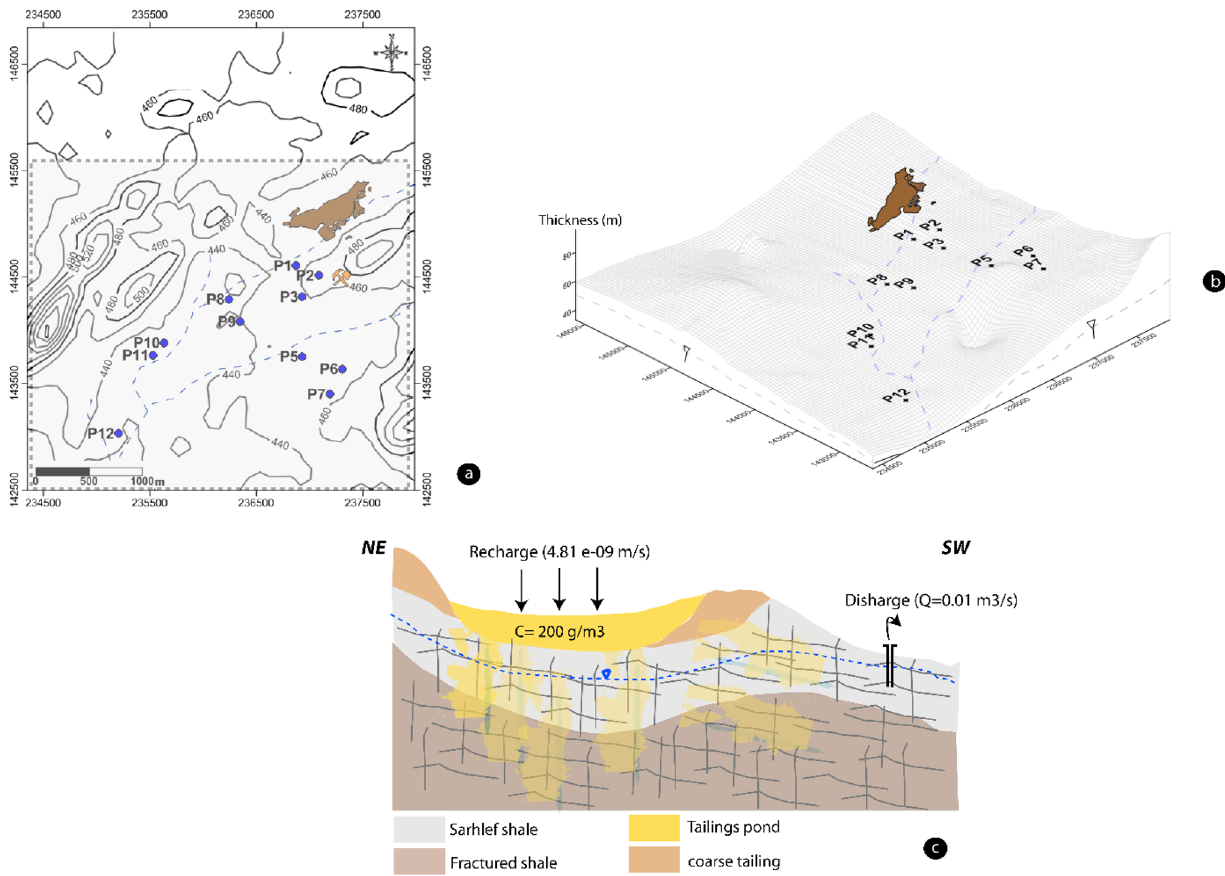
Fig. 4 a Location of the study area on a topographic map, b Sarhlef shale aquifer geometry and c schematic conceptual model